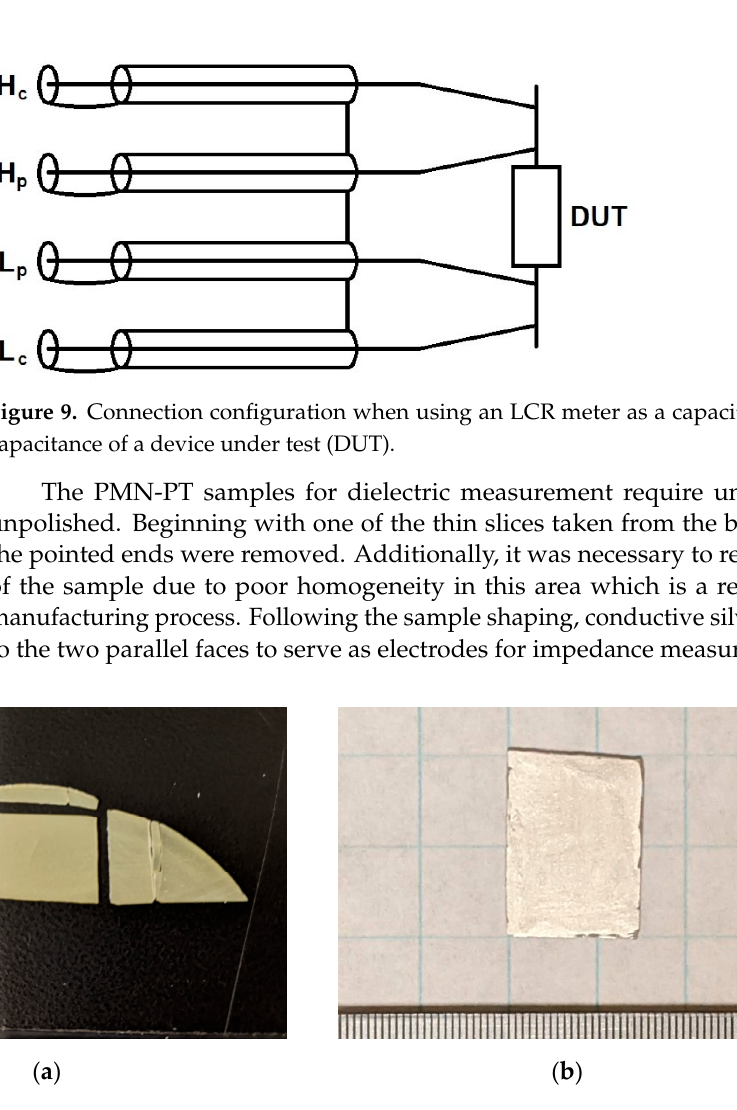
Table 3. Expectation values for the capacitance measurements of x-cut and z-cut lithium niobate (LiNbO 3 ) single crystal samples.